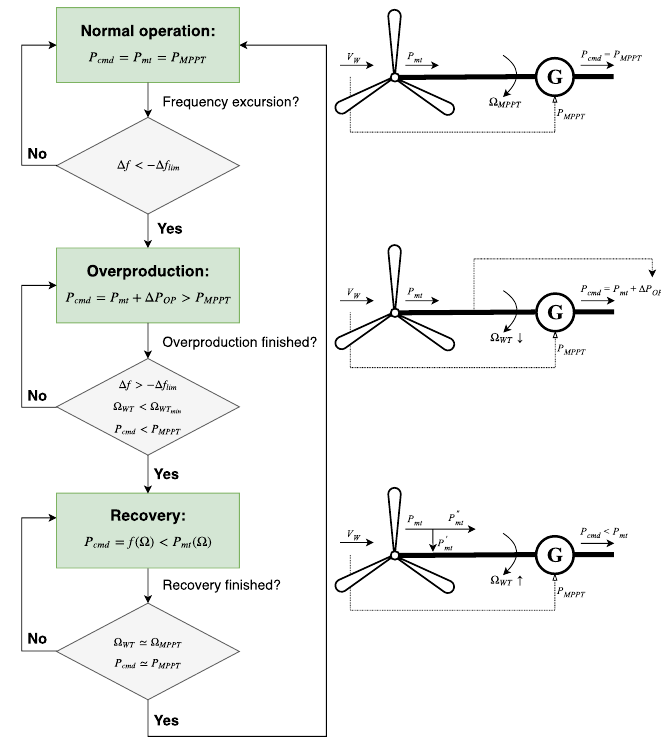
Figure 2. Scheme of the proposed VSWTs frequency controller